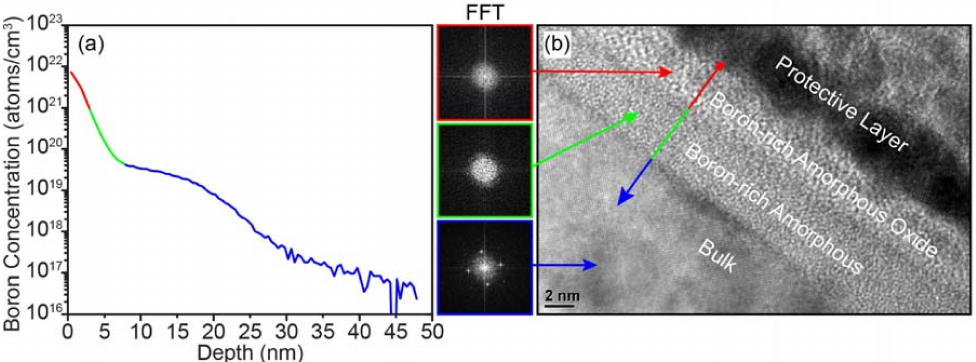
Figure 1. The Secondary Ion Mass Spectroscopy (SIMS) and cross-sectional Transmission Electron Microscopy (TEM) analyses of the boron-implanted silicon substrate revealed: ( a ) The boron concentration depth profile, and ( b ) structure of the substrate. The boron concentration at the surface of the substrate was ~14.6 atomic percent, and the majority of the boron was found within ~7 nm from the surface. The red, green, and blue colors on the plot ( a ) and the line in ( b ) correspond to the boron-rich amorphous oxide layer, the boron-rich amorphous layer, and the bulk silicon, respectively. The cross-sectional TEM image and the Fast-Fourier Transforms (FFTs) of the image showed that both outer layers were amorphous, and that the bulk was crystalline. The platinum protective layer was deposited onto the substrate surface prior to fabrication of the TEM specimen using focused-ion beam